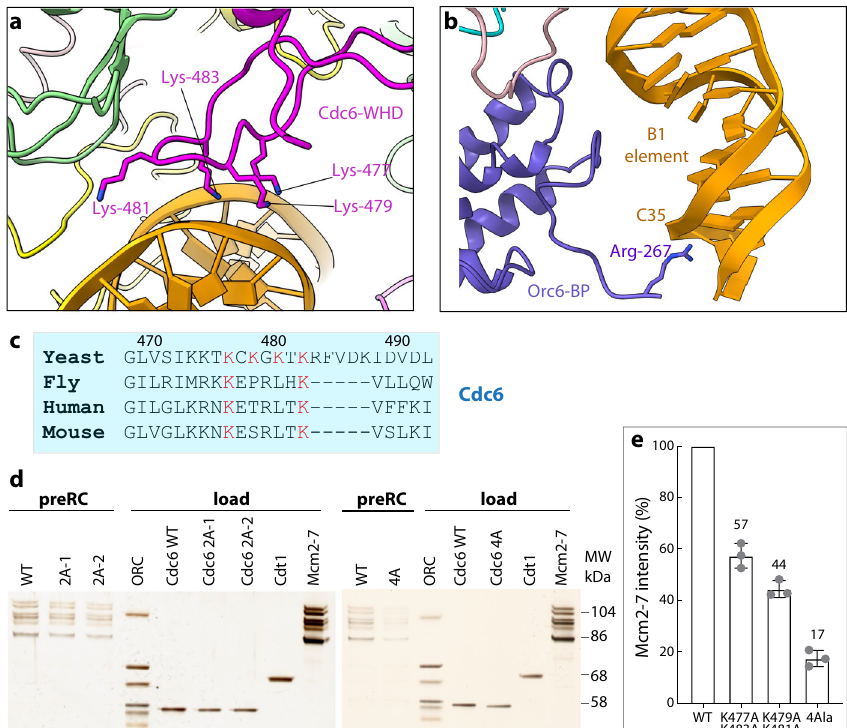
Fig. 3 The yeast Cdc6 increased the binding interface to the origin DNA. a DNA binding β -hairpin structure in the Cdc6 WHD. The four lysine residues contacting DNA are shown as sticks. b The new DNA binding Arg-267 in the Orc6-BP in the ORC – Cdc6 structure. c The fi rst and fourth DNA-interacting Cdc6 β -hairpin lysine residues are conserved in eukaryotes. d Pre-RC reaction with Cdc6 wild-type (WT), Cdc6 K477A/K483A (2A-1), Cdc6 K479A/ K481A (2A-2), or Cdc6 K477A/K479A/K481A/K483A (4A or 4Ala) was assembled, washed with high salt, and analyzed by silver staining. Puri fi ed Orc1 (104 kDa), Mcm5 (86 kDa), Cdt1 (68 kDa), and Cdc6 (58 kDa) are used as molecular weight markers. e Mcm5 intensities of the Mcm2-7 double hexamer in ( d ) were quanti fi ed by ImageJ (version 1.50i) and the relative Mcm5 intensities were plotted using three independent experiments. The center for the error bar is the average of three measurements. The amount of Mcm5 was used as an indicator for the Mcm2-7 loading ef fi ciency of the WT ORC in partner with the mutant Cdc6. Each reaction was done three times independently. Individual data points are shown as gray dots. Error bars represent standard